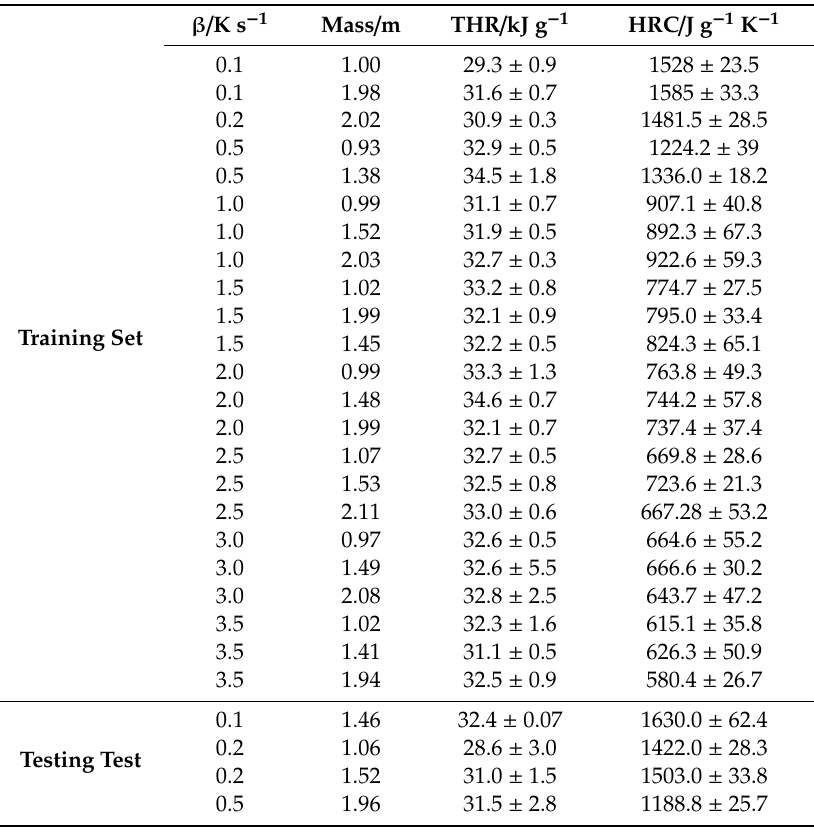
Table 6. Training and testing